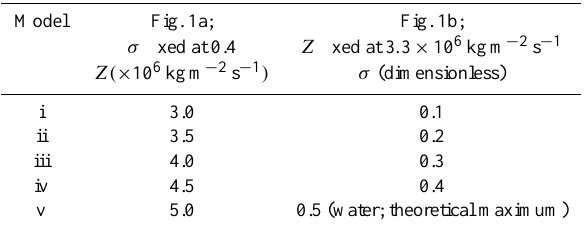
Table 1. Model properties for example AVA curves in Fig. 1. In Fig. 1a, Poisson’s ratio ( σ ) is fixed at 0.4; in Fig. 1b, acous- tic impedance ( Z) is fixed at 3 . 3 × 10 6 kgm − 2 s − 1 . Acoustic impedance for ice, bedrock and water are 3 . 5 × 10 6 kgm − 2 s − 1 , 14 . 0 × 10 6 kgm − 2 s − 1 and 1 . 5 × 10 6 kgm − 2 s − 1 , respectively; cor- responding Poisson’s ratios are 0.333, 0.296 and 0.500 (e.g., Peters